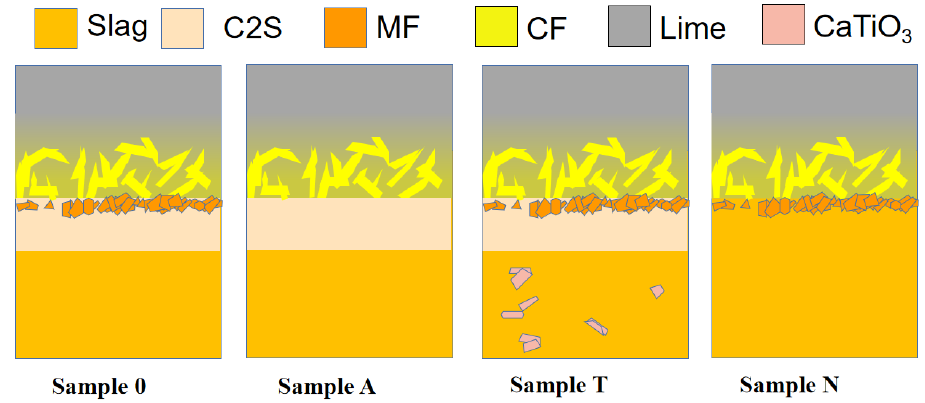
Figure 11. Phase change diagram for lime dissolution.